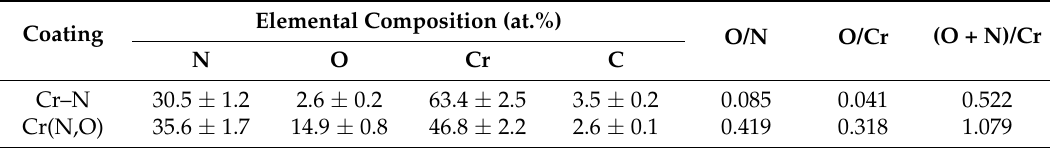
Table 2. The elemental composition of the monolayered coatings deposited on Si substrates. Elemental Composition Coating